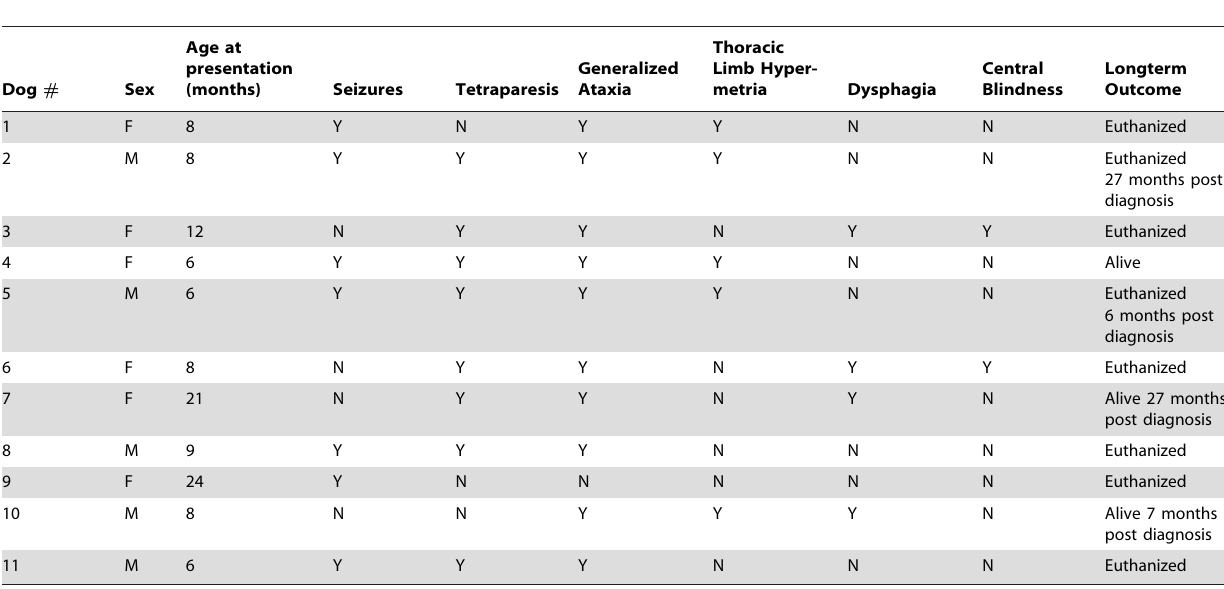
Table 1. Signalment, Presenting Clinical Signs, and Long Term Outcome of Alaskan Huskies with AHE.